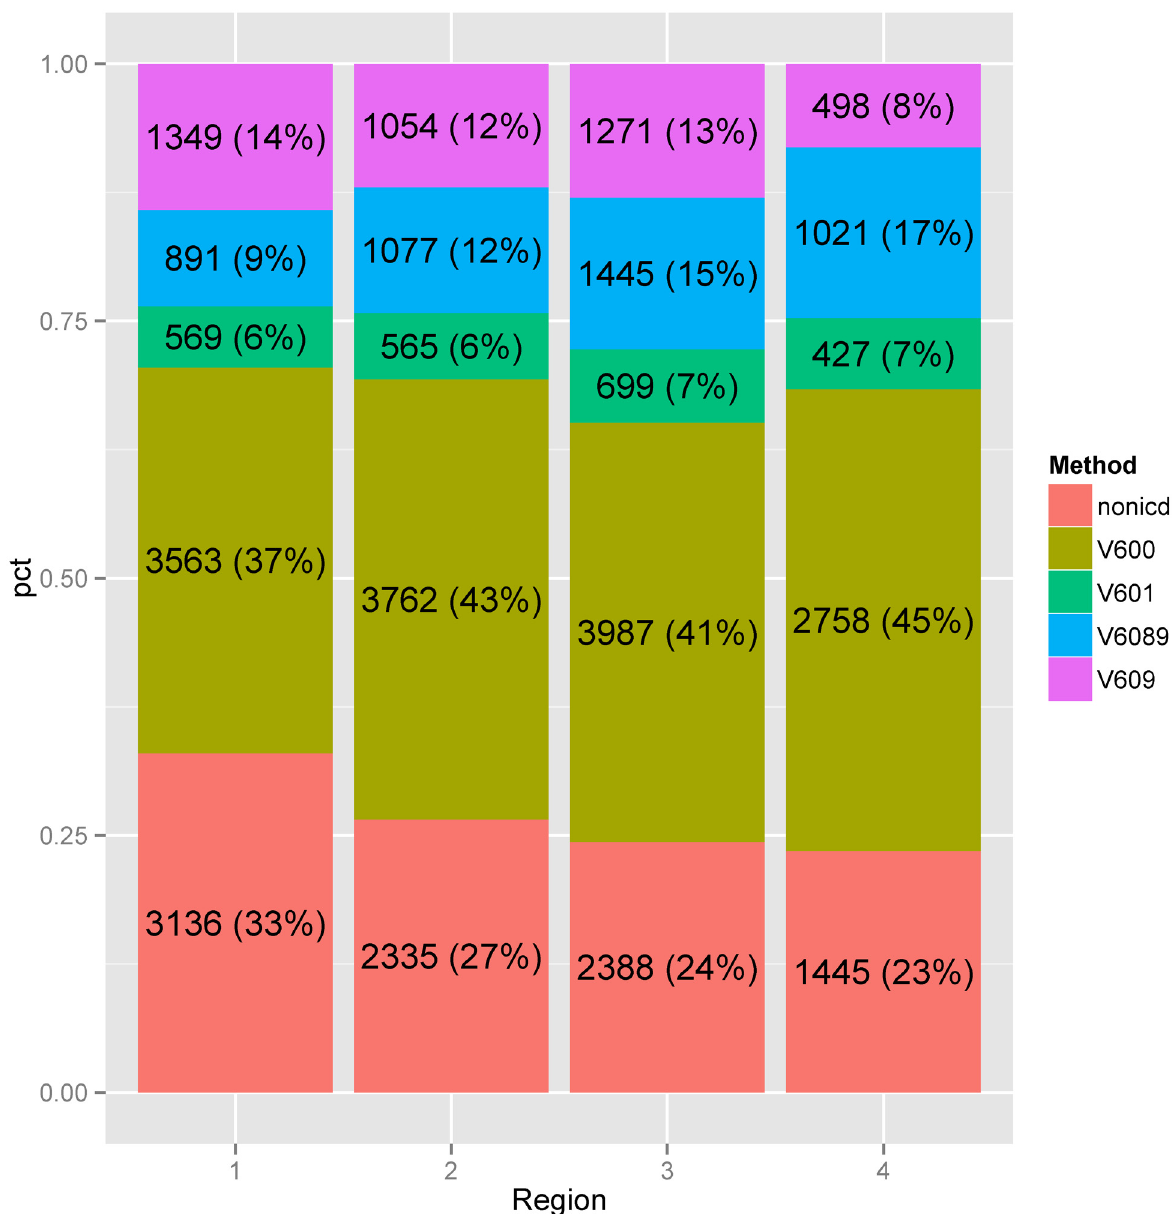
Fig 2. A stacked bar graph of the variability in usage of V60 and non-ICD codes to identify homelessness among Veterans across 4 VA regions in the US. Region 1 includes the East Coast, Region 4 the West Coast. The time period studied is 2002 –